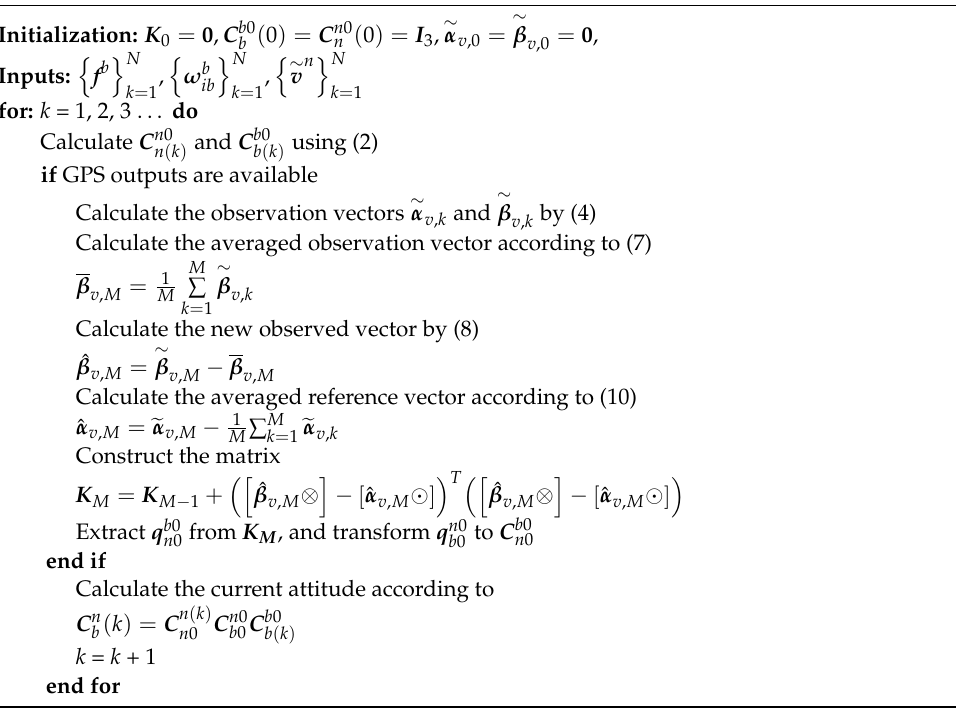
Algorithm 1. Initial alignment method for SINS/GPS